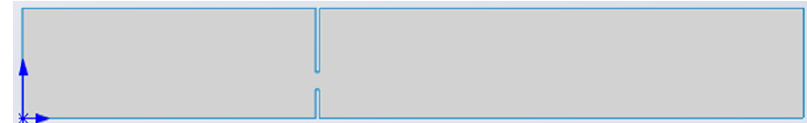
Figure 3. Two-dimensional roadway